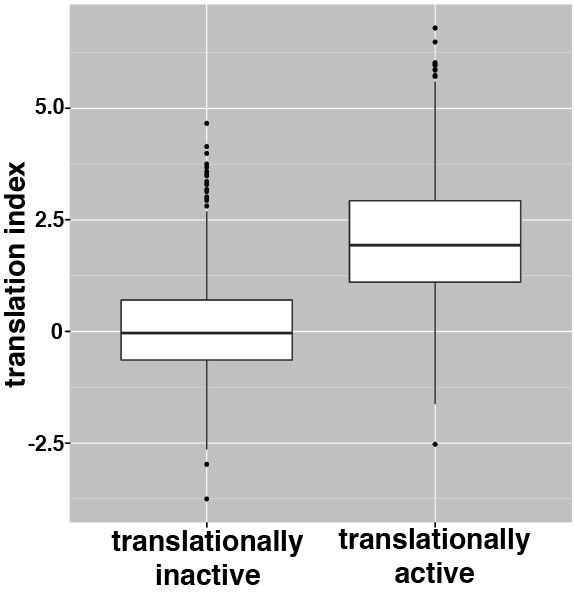
Validation of polysome-gradient microarrays. TIs calculated in this study were used to generate box plots to compare the range of TIs for genes that were previously categorized in Qin et al. [8] as ‘translationally active’ or ‘translationally inactive’ in embryos from the same developmental stage.